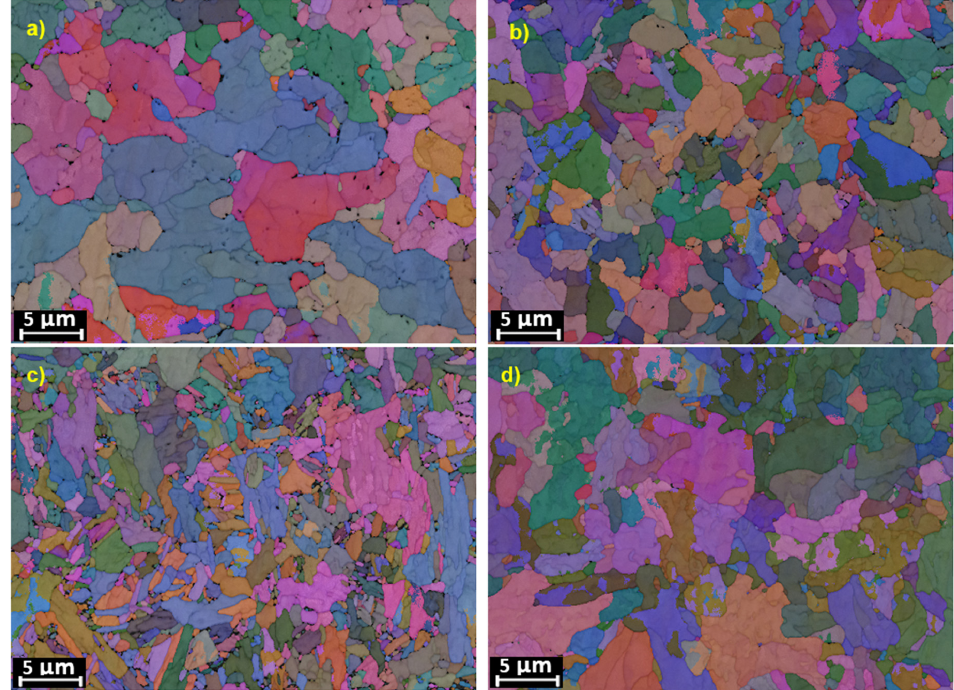
Figure 3. EBSD mapping of the microstructures in the LAS HAZ of the NIWEL 5000 h condition, at different distances from the FB. Progressive grain refining of distance from ( a ) 2500, ( b ) 1000 to ( c ) 300 μ m to FB, and grain coarsening at ( d ) 30 μ m to the FB were observed.